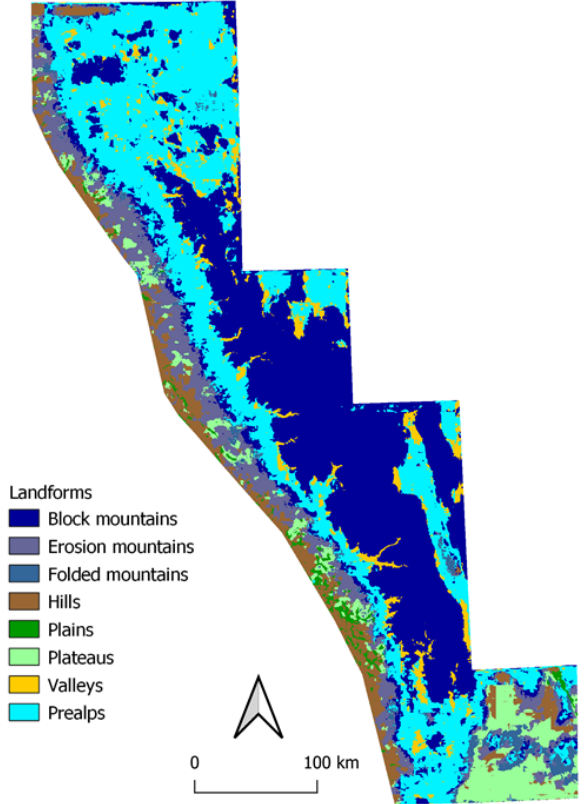
Figure 14. Predictions for the Sierra Nevada mountain range.